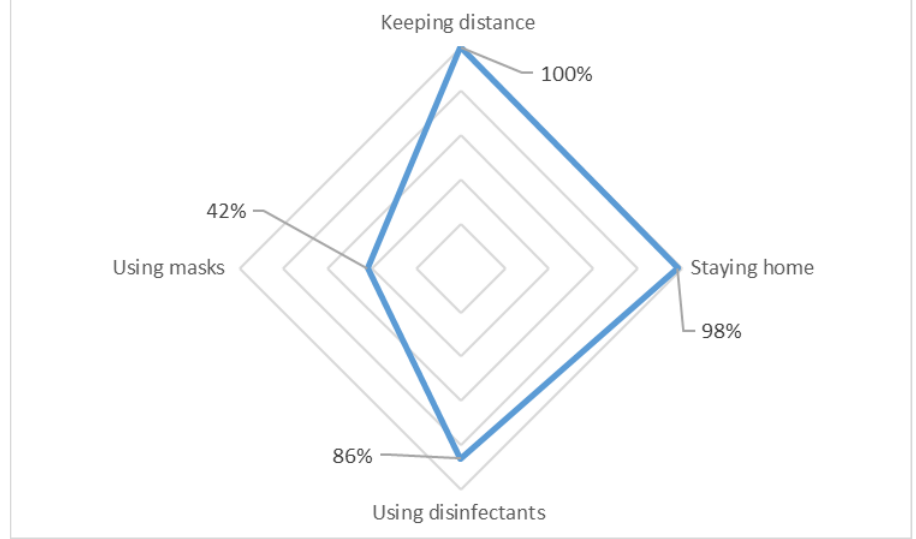
Figure 9. General activities to which miners adhered. Own study based on [49].